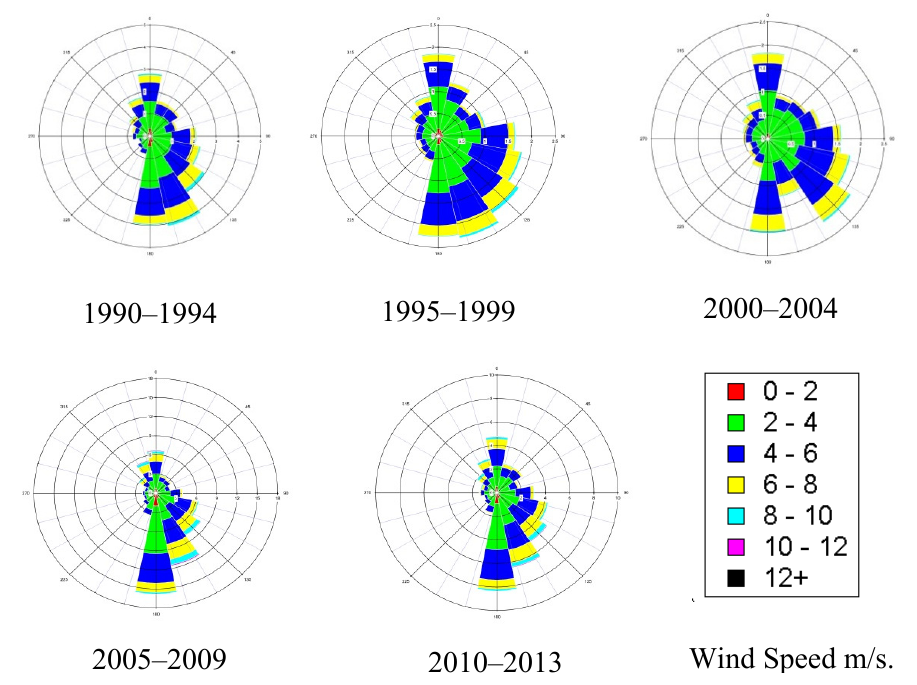
Figure 9. Wind speed and direction as a function of time for George Bush Airport